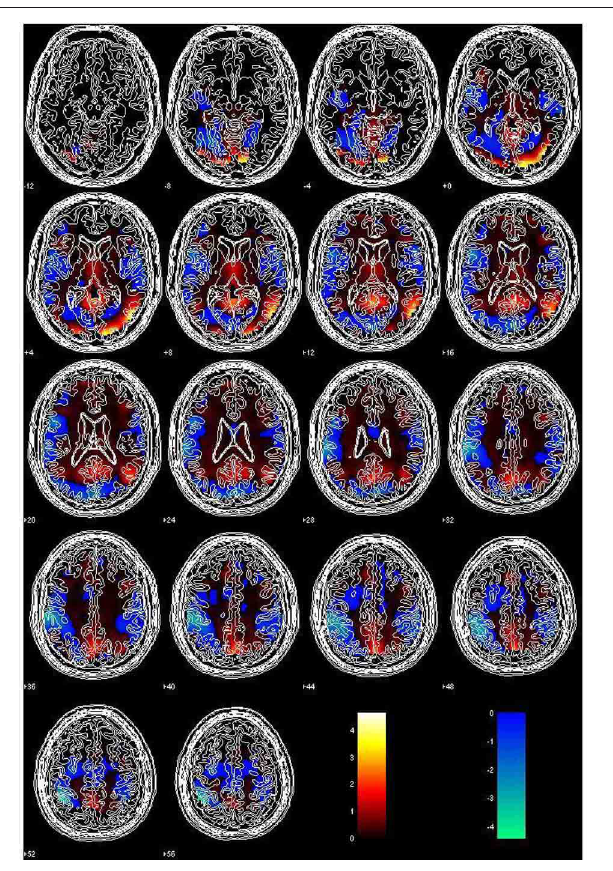
FIGURE 1 | The activation maps of the two contrasts (hot color: mammal > tool; cool color: tool > mammal) computed from the 10 datasets of our participants. The apparently sharp cutoff of values in the most ventral slices was not due to the mismatch with the contours of the normalized space, but to the relative narrowness and the shape of the coverage extent (due to only 15 oblique slices as the result of TR = 1s), which was the logical AND of the individual coverage